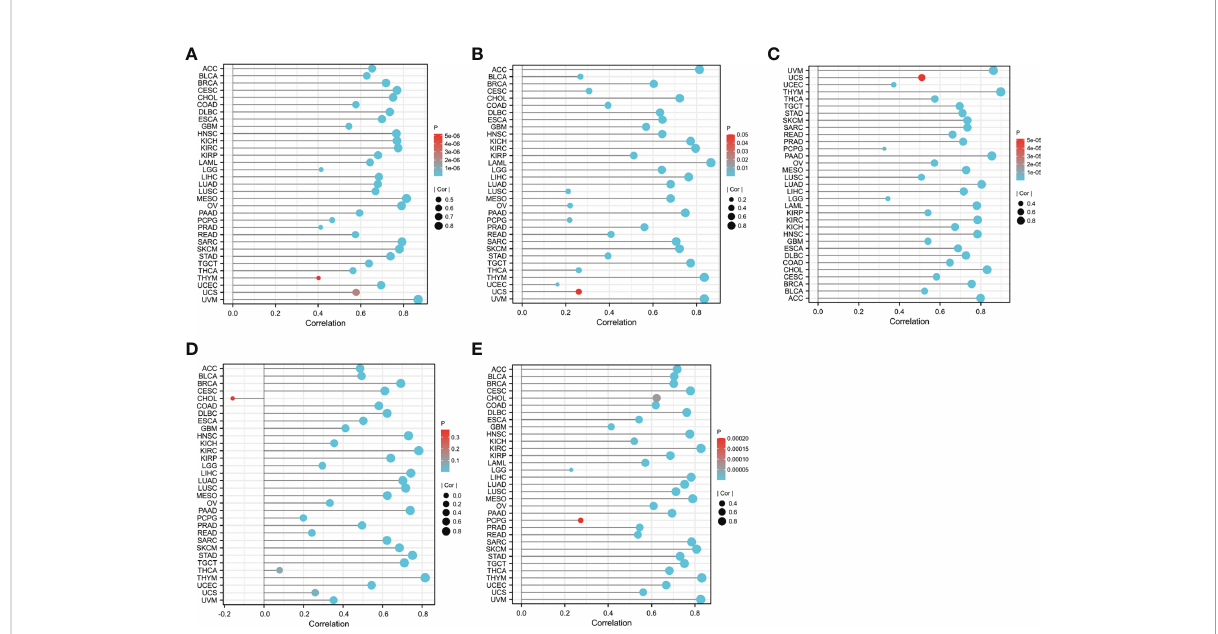
FIGURE 5 The relationship between CD8A expression levels and the degree of CD8+ T cell in fi ltration in different cancers was statistically signi fi cant at P<0.05: (A) CIBERSORT. (B) MCP-counter. (C) QUANTISEQ. (D) TIMER. (E)